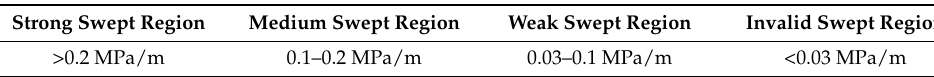
Figure 2. Pressure gradient distribution of five-spot and inverted seven-spot well patterns simulated by the tNavigator. ( a ) Five-spot well pattern, ( b ) inverted seven-spot well pattern. The stable pressure data are derived, and the central difference method in Equations (4) and (5) is used to solve the distribution of the pressure gradient in the X and Y direc- tions. It should be noted that the solution at the grid boundary adopts the unilateral dif- ure S2). Table 2. The classification criteria of the four swept regions.